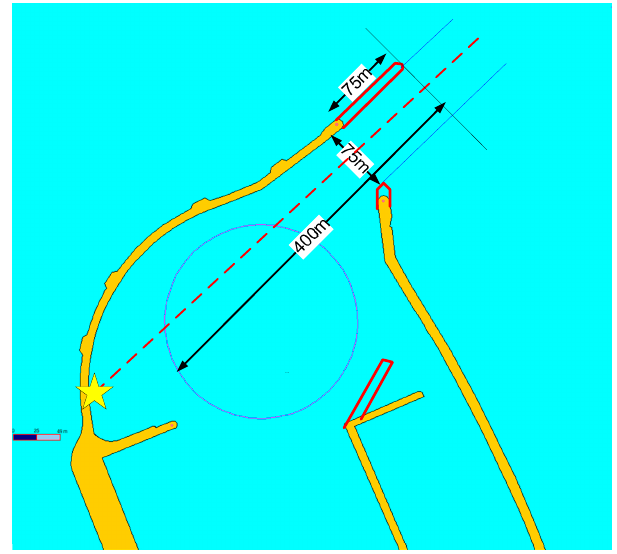
Figure 2. Ustka Port—the preliminary design (yellow) and proposed changes in the breakwater after wave conditions modelling inside the port (red).